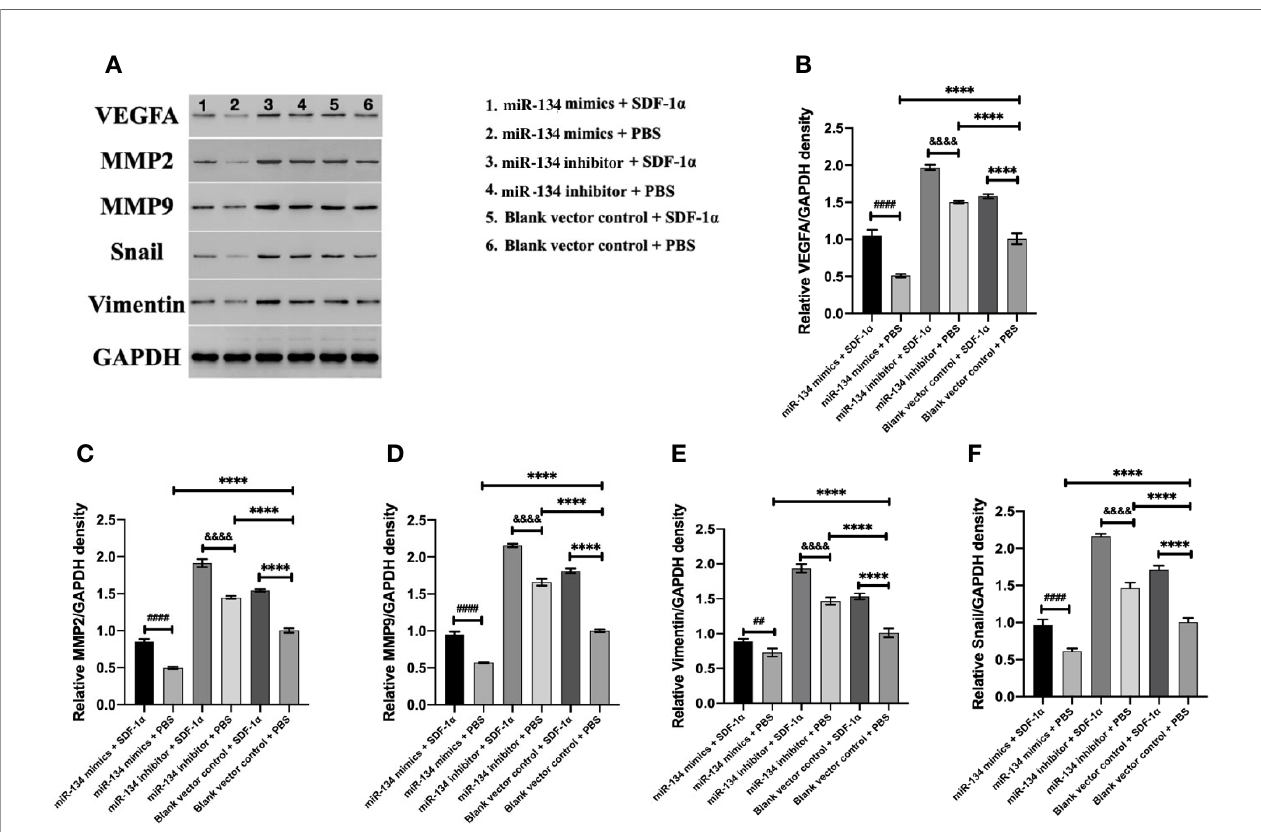
FIGURE 4 | The expression of VEGFA and proliferation/invasion-related downstream protein of a T3-1 cells. (A) Schematic diagram of the target protein band. (B) The quanti fi cation of VEGFA expressions using western blot analysis. (C) The quanti fi cation of MMP2 expressions using western blot analysis. (D) The quanti fi cation of MMP9 expressions using western blot analysis. (E) The quanti fi cation of Vimentin expressions using western blot analysis. (F) The quanti fi cation of Snail expressions using western blot analysis. Data were represented as means ± SD (n = 5). #### p < 0.0001 and ## p < 0.01 vs. miR-134 mimics + PBS group. &&&& p < 0.0001 vs. miR-134 inhibitor + PBS group. **** p < 0.0001 vs. black vector control + PBS